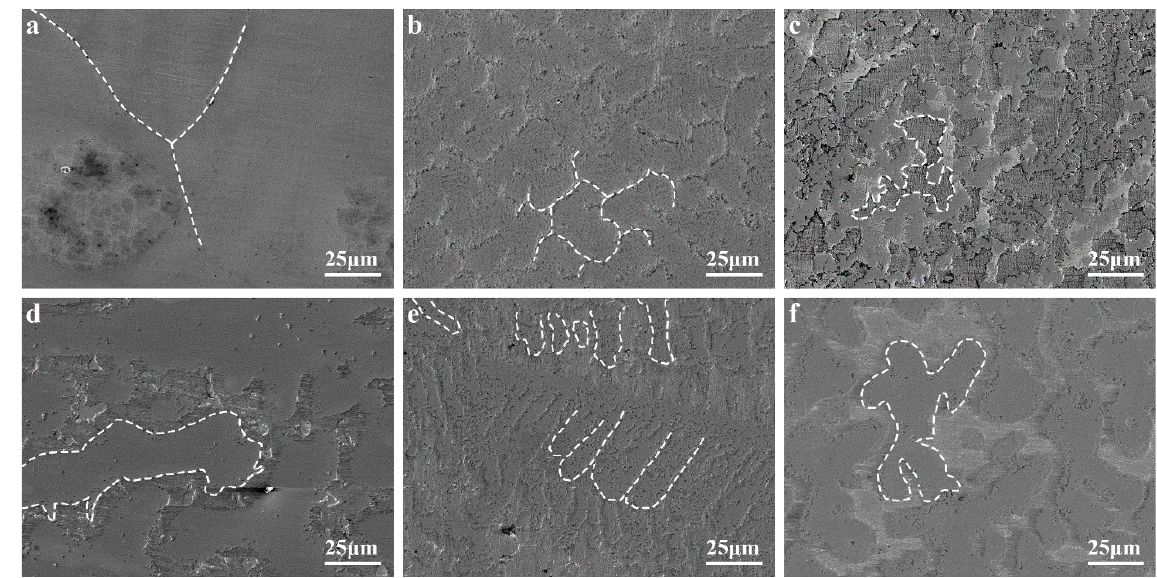
Figure 3. SEM micrographs of the AlCrTiV 0.5 Cu x lightweight HEAs. ( a ) x = 0; ( b ) x = 0.2; ( c ) x = 0.4; ( d ) x = 0.6; ( e ) x = 0.8; ( f ) x = 1.0.